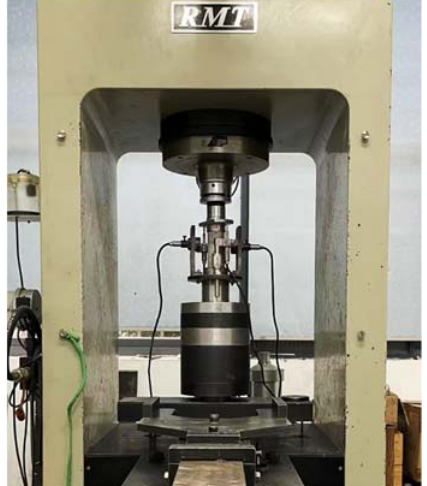
Figure 8. Rock mechanics test system (RMT).